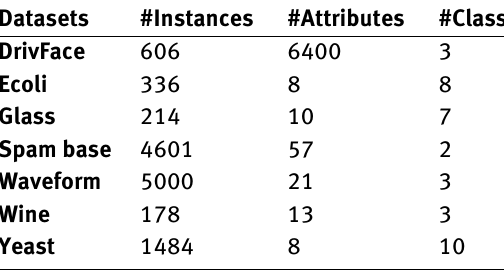
Table 1: Some Characteristics of